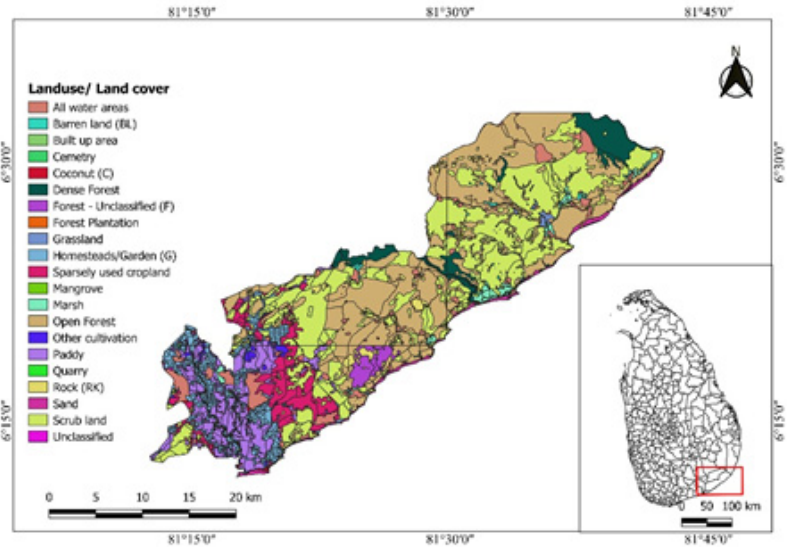
Figure 3. Landuse patterns in Tissamaharama DSD.